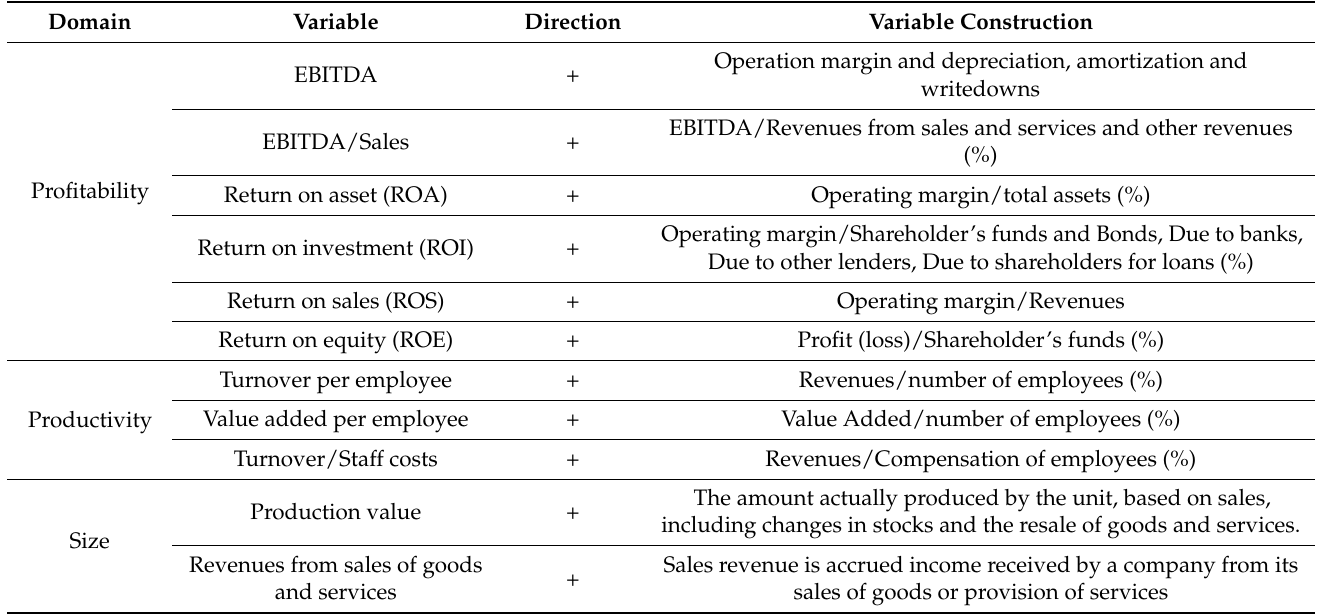
Table 2. List of variables used to derive the composite performance index (SP-score) for the